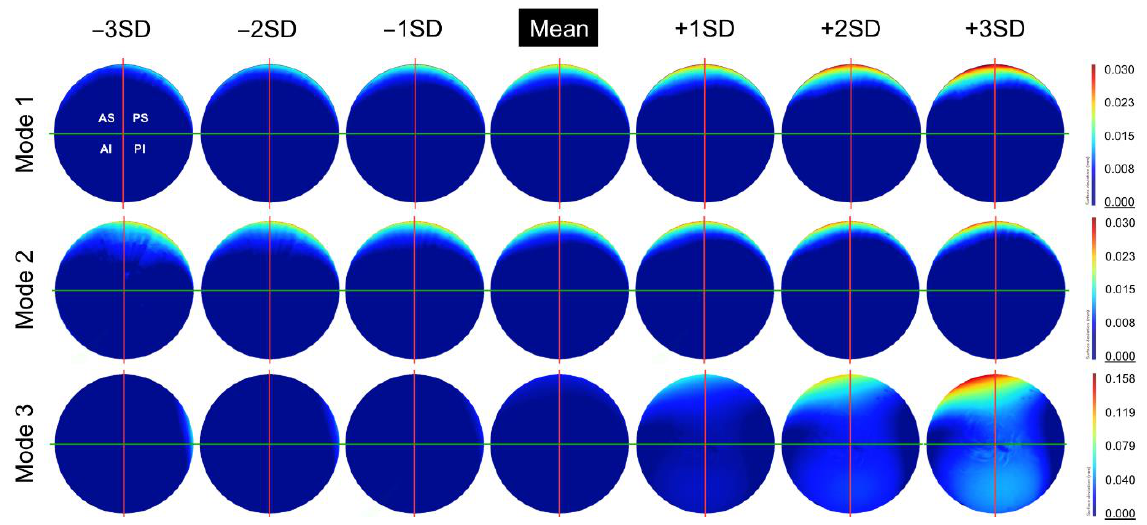
Figure 6. Presenting (1) the mean acetabular surface generated through a PCA of the population (n = 19), following the exclusion of a single surface. This is presented as deviation map of their comparison with the as-manufactured reference surface, where the dark blue regions are considered unworn. Its orientation within the pelvis is also presented (2), along with a 3D representation of the wear map (3).